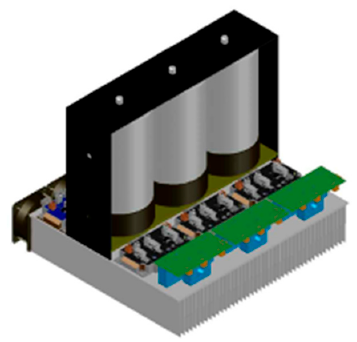
Figure 12. 3D rendering of the power electronics converter.